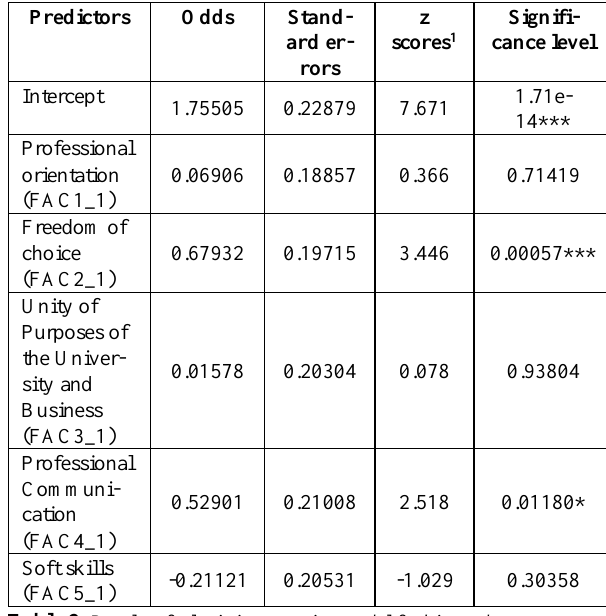
Table 2. Results of a logistic regression model for binary